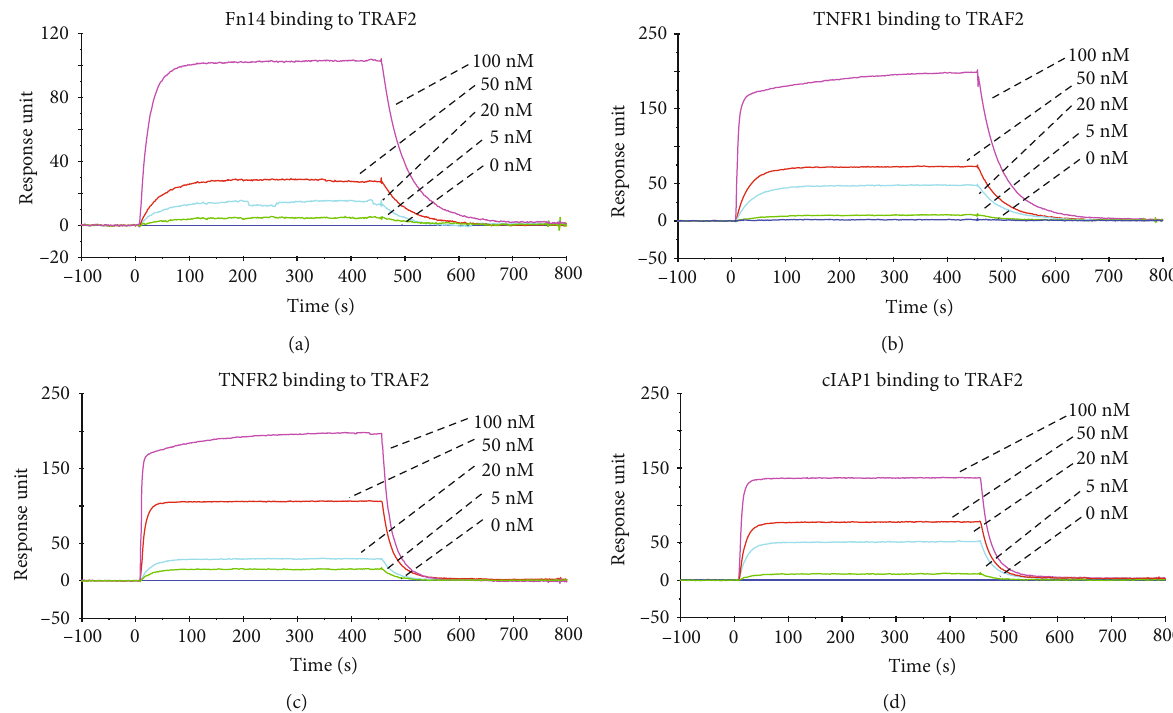
Figure 2: The speci fi c binding of Fn14, TNFR1, or cIAP1 to TRAF2 molecule. These recombinant proteins were analyzed by SPR. TRAF2 protein was immobilized to a sensor chip, followed by running Fn14 (a), TNFR1 (b), TNFR2 (c), or cIAP1 (d) protein at a concentration rage of 0 – 100 nM. Data were obtained from fi ve independent experiments. Representative images are